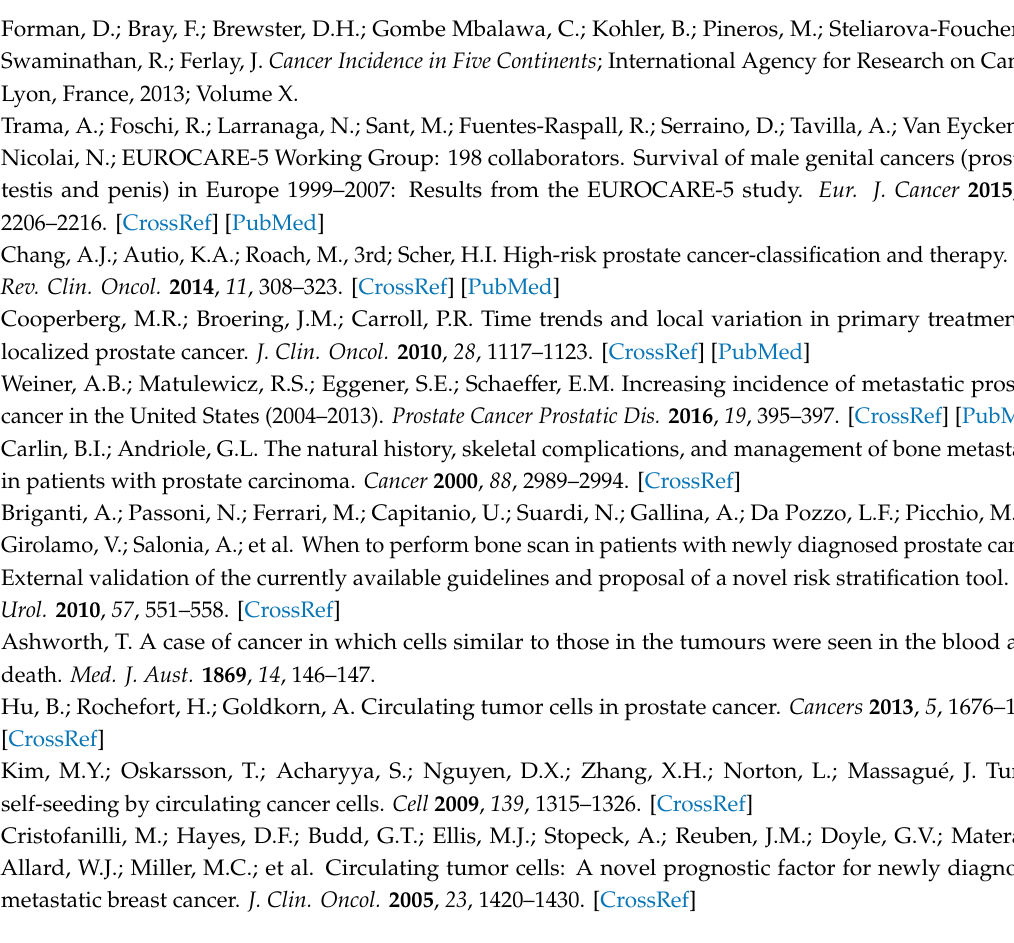
Table S1: Spearman ( R ) coe ffi cient of correlation between CTC counts determined with various assays, age and clinical characteristics of prostate cancer patients, Table S2: Distribution of clinical characteristics in prostate cancer patients who tested positively ( + ) or negatively (–) for CTCs with various assays, Table S3: Distribution of patients with distant metastases of prostate cancer who satisfied individual criteria of tested diagnostic